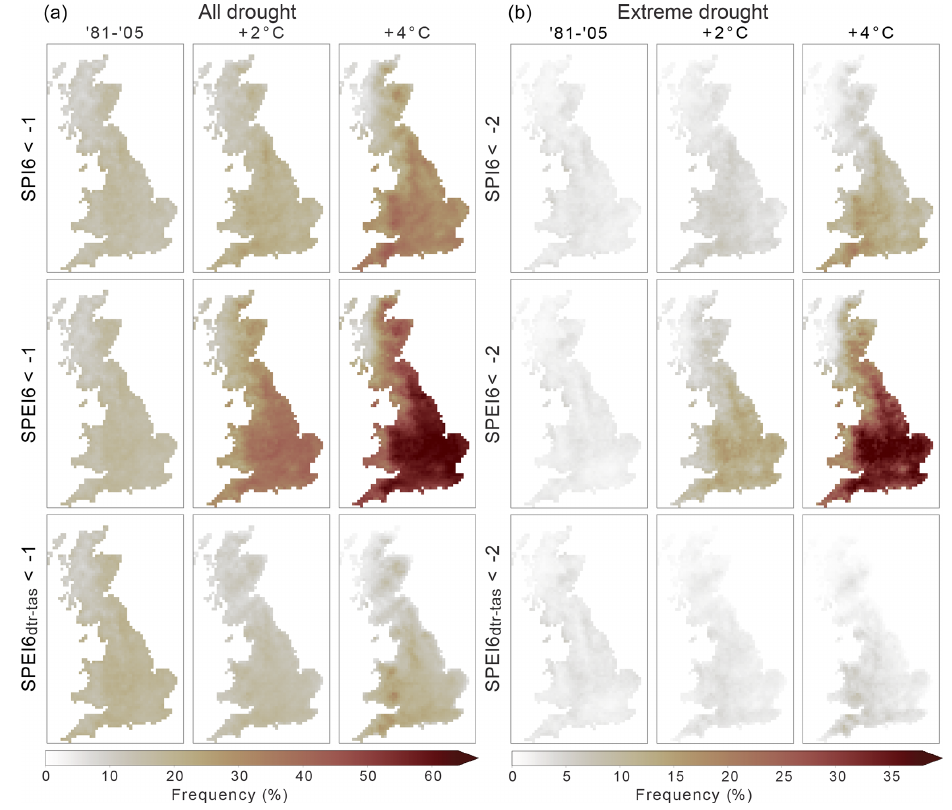
Figure 5. Ensemble-averaged projected frequency of all (a) and extreme (b) dry conditions expressed as the fraction of time that the SI falls below − 1 or − 2 respectively. The top row shows the SPI6, the middle row displays the SPEI6 with projected temperature changes and the bottom row shows the SPEI6 with detrended